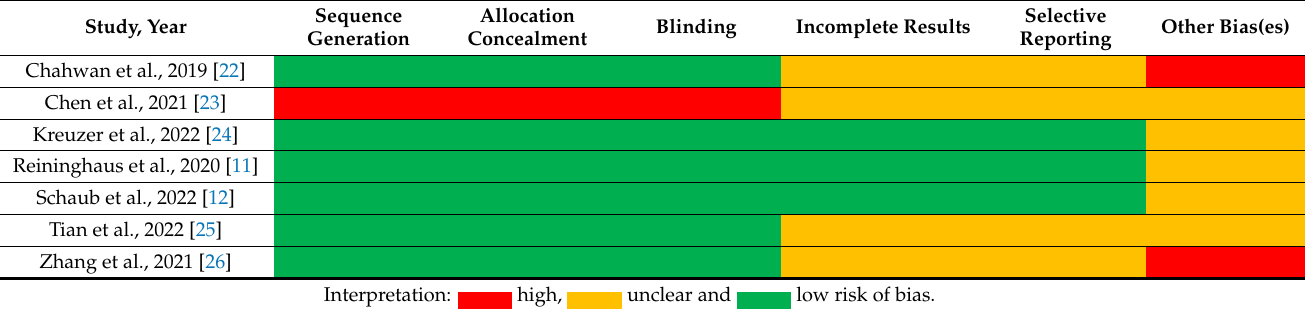
Table 2. Risk of bias assessment for the studies